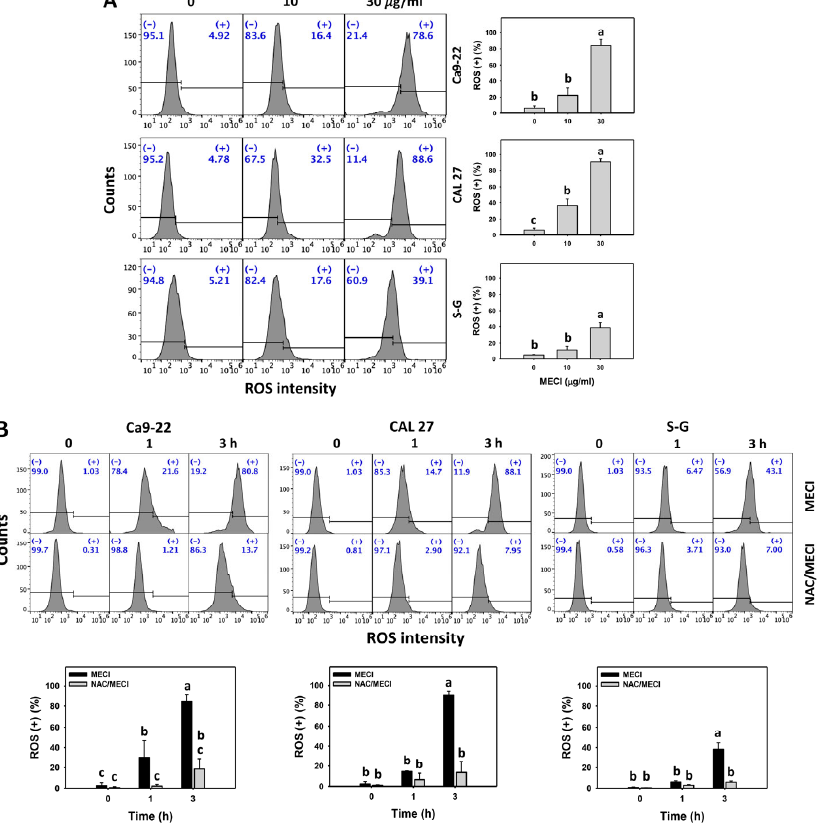
Figure 6. ROS assay. ( A ) ROS change. Except for S ‐ G cells, other cells were oral cancer cells. After 3 h MECI incubation (0 (0.1% DMSO in the medium), 10, and 30 μ g/mL), cells were applied to an ROS assay. (+) spots were specified for ROS (+). ( B ) Impact of NAC on MECI ‐ induced ROS change to oral cancer cells. After pretreatment with NAC, cells were post ‐ treated with MECI (30 μ g/mL) for 0, 1, and 3 h. Data, mean ± SD ( n = 3). For the same cell line, columns showing non ‐ overlapping letters differ significantly ( p < 0.05).